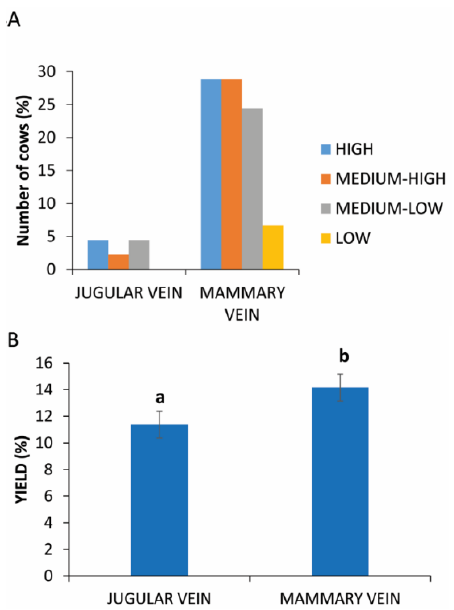
Figure 4. PRP yield between two different sites of blood collection. ( A ) Distribution (%) of cows in different PRP yield classes considering the collection in mammary or jugular vein. ( B ) Comparison of PRP yield between two different sites of blood collection. Values are expressed as means and standard deviations. Different letters represent statistically significant differences.